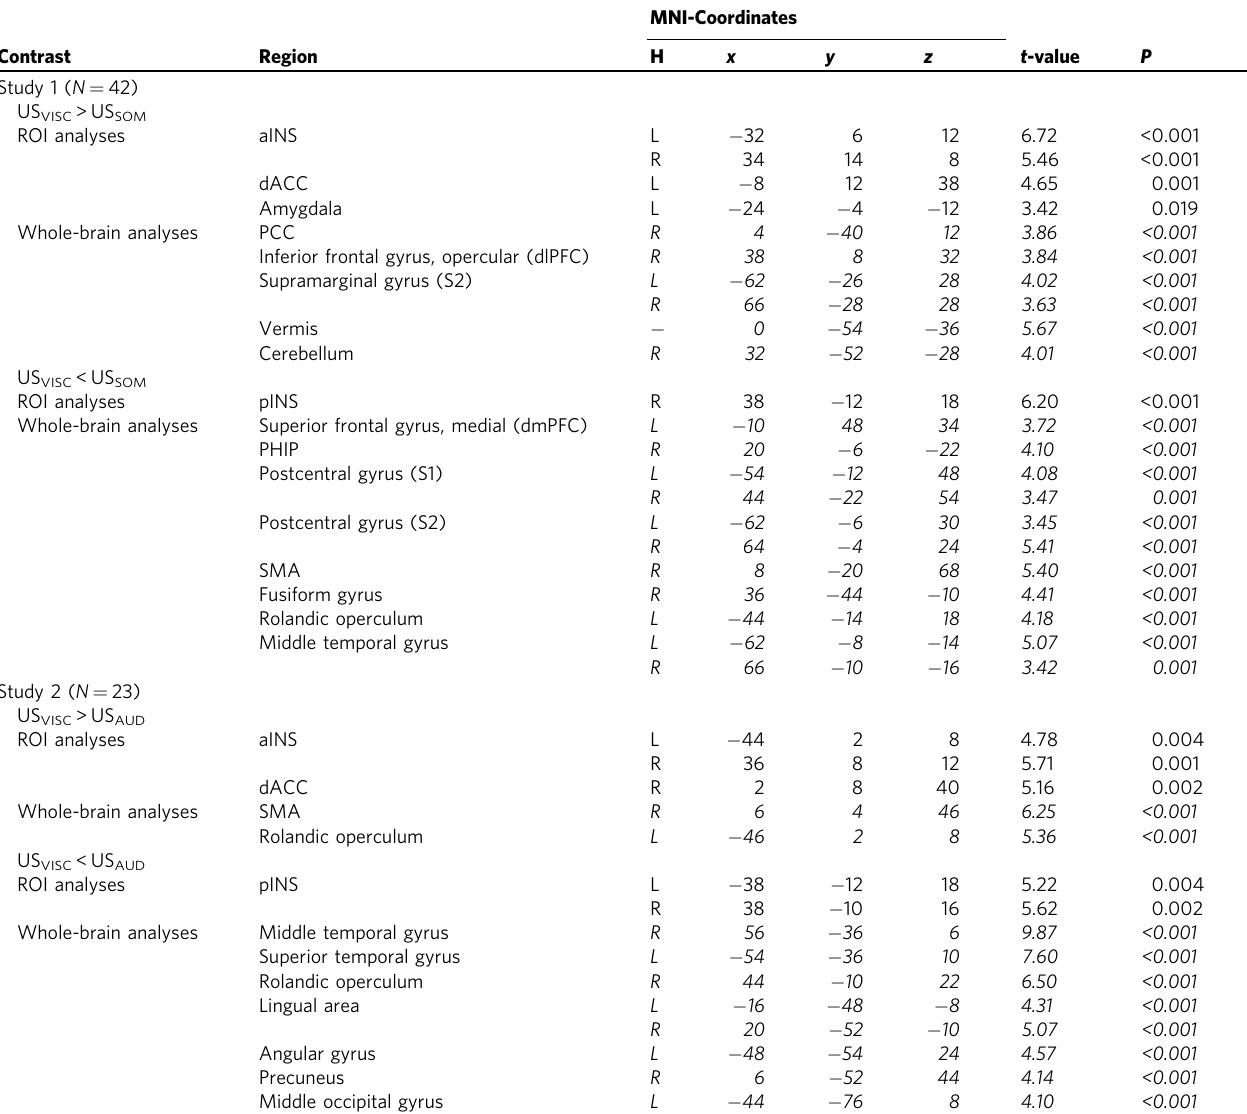
Table 1 Differences in neural activation induced by interoceptive versus exteroceptive threats as unconditioned stimuli (US) during